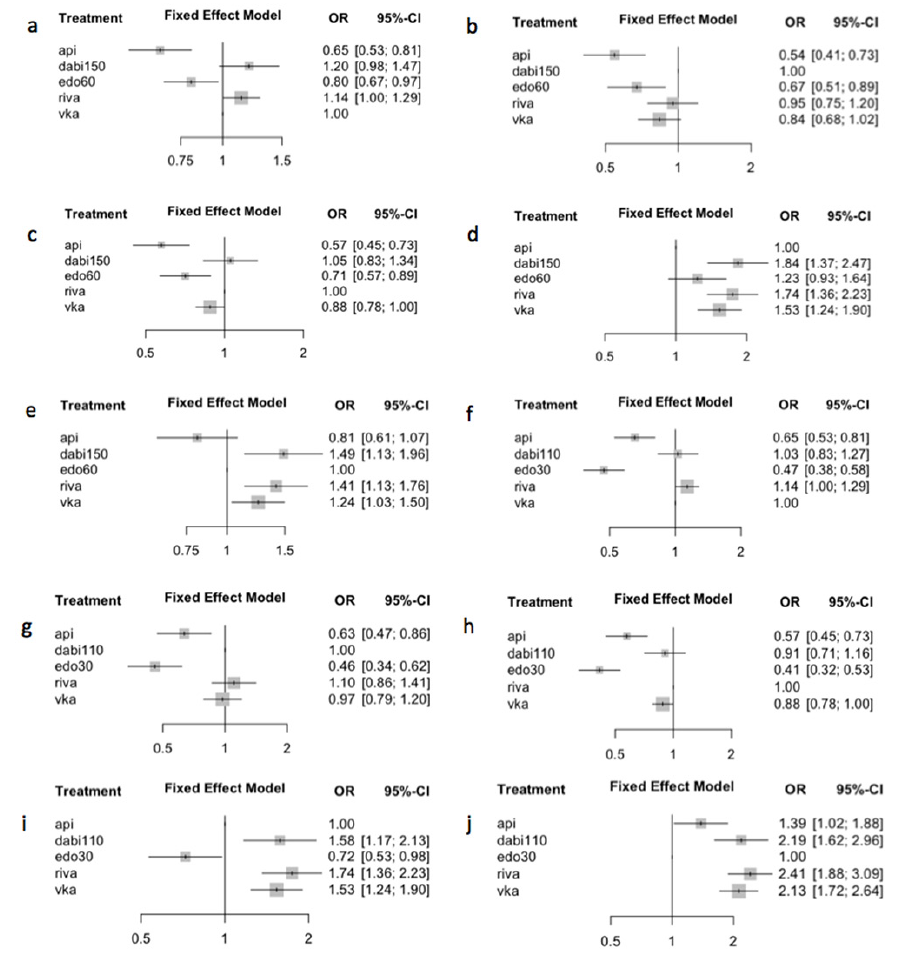
Forest plots of indirect comparisons between direct oral anticoagulants for major and clinically relevant non-major bleeding including high- dose dabigatran and edoxaban (a–e) and low-dose dabigatran and edoxaban (f–j). api = apixaban; CI = confidence interval; dabi110 = dabigatran 110 mg; dabi150 = dabigatran 150 mg; edo30 = edoxaban 30 mg; edo60